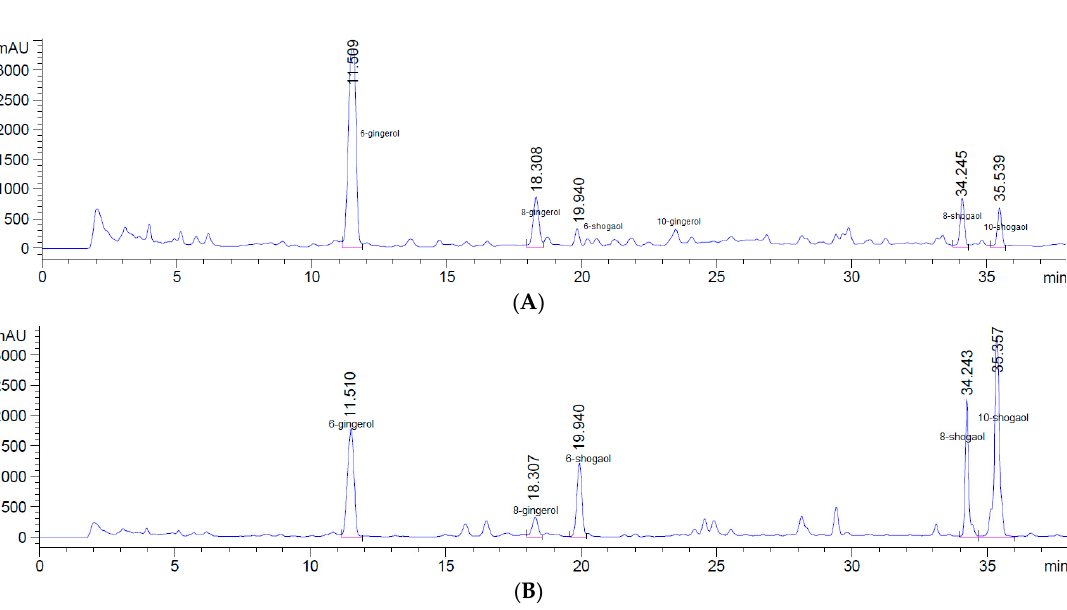
SD: sun drying; HAD: hot air drying. OSD; open sun drying; STD: solar tunnel drying; Data were the mean ± standard deviation of triplicate measurements. Different superscript lower case letters in each row indicated significant difference at p < 0.05 (Duncan’s test).